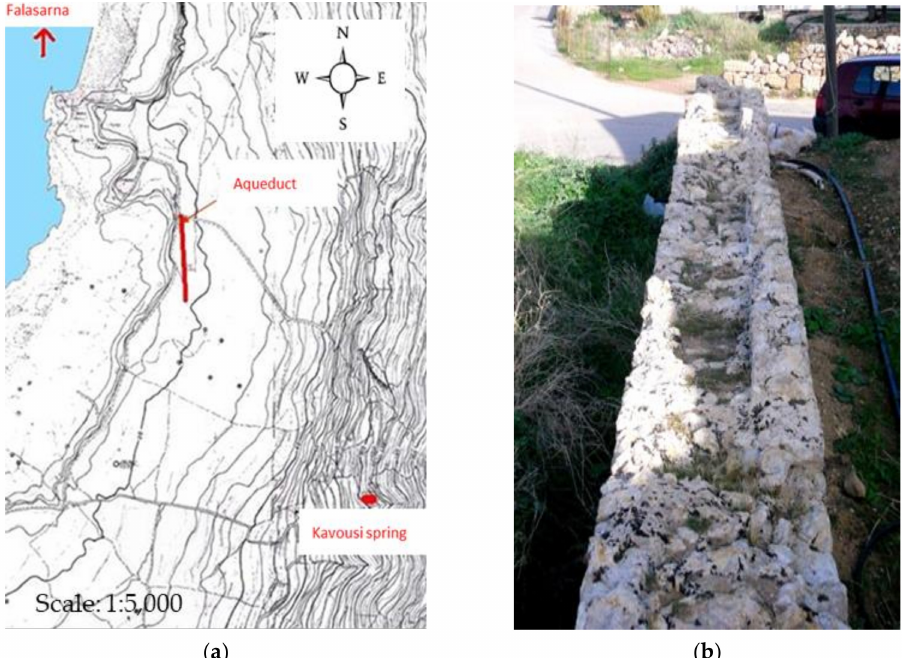
Figure 12. The aqueduct of ancient Falassarna: ( a ) Preserved part of aqueduct, background scale 1:5000 (provided by Y. Christodoulakos on background of the Hellenic Military Geographical Service maps [38]) and ( b ) channel remains (photo taken by Y.